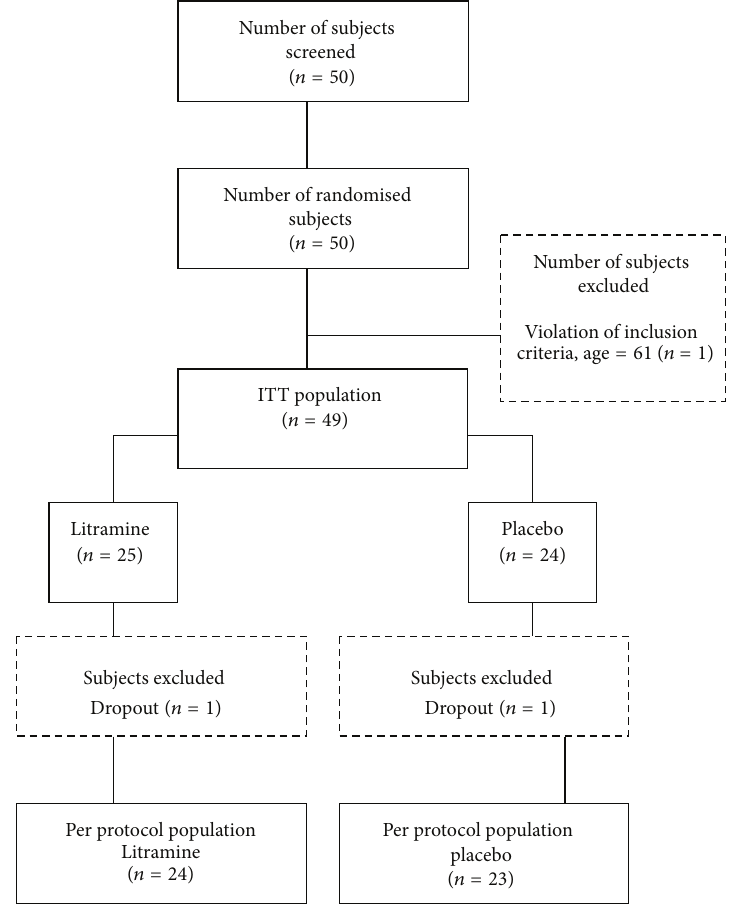
Figure 1: CONSORT diagram on study